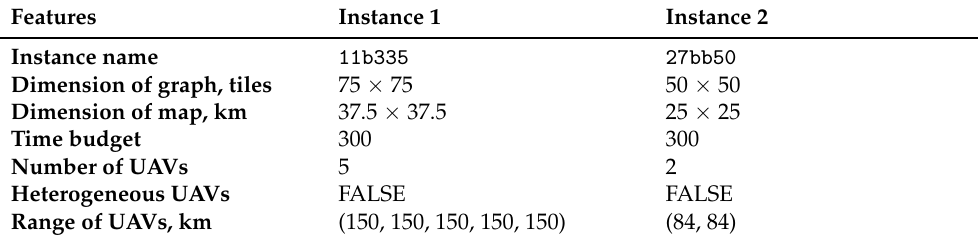
Figure 6. The two map instances used for parameter tuning. ( a ) Score map of the instance 11b335 . ( b ) Score map of the instance 27bb50 . Table 4. The features considered for parameter tuning for the two problem instances.